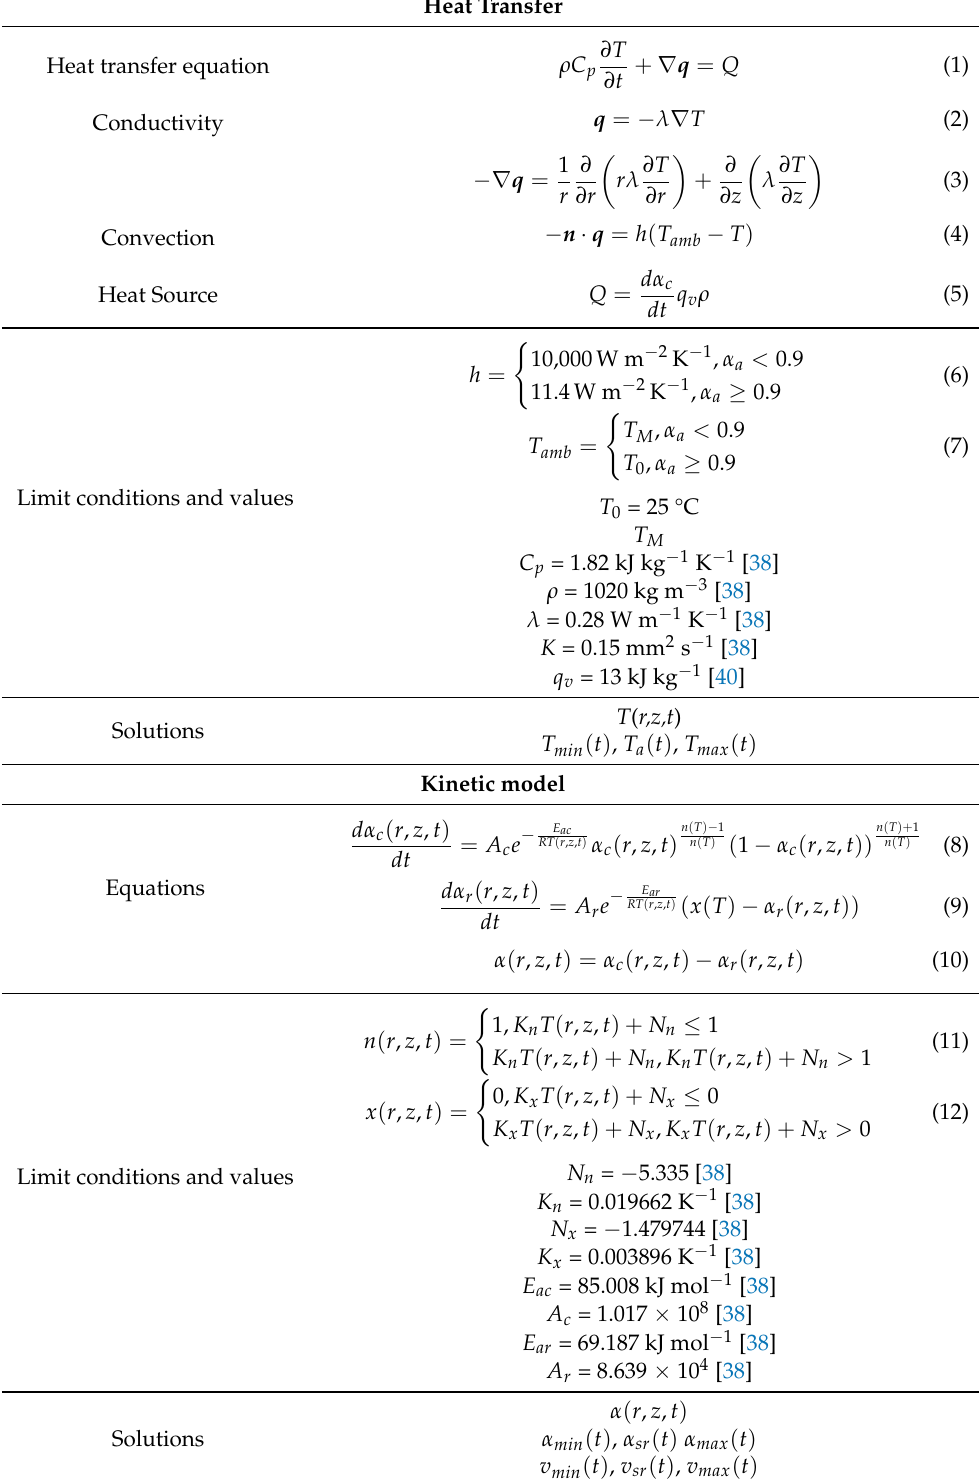
Table 1. Coupled equations of heat transfer and kinetic